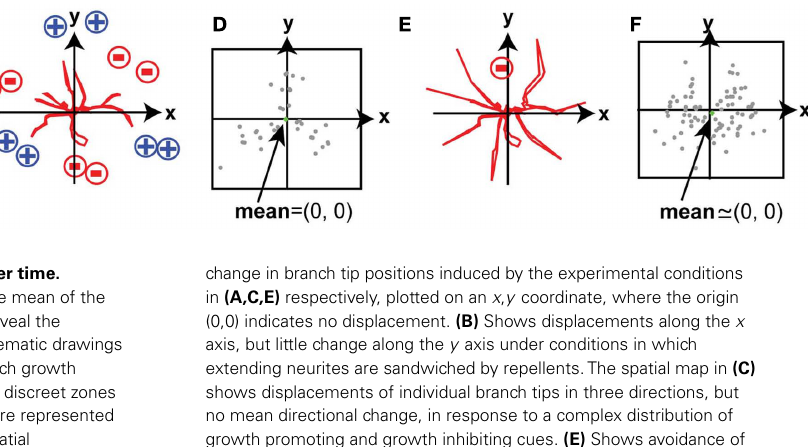
FIGURE 1 | Spatial displacements of branch tips over time. Examples of instructed growth of neurites, in which the mean of the displacement vectors of individual neurites does not reveal the presence of directional instructive signals. (A,C,E) Schematic drawings that show representative experimental contexts in which growth inhibitory cues are presented in a stripe assay (A) or in discreet zones (C,E) , where growth inhibition and growth promotion are represented by negative and positive signs, respectively. (B,D,F) Spatial representations of branch tip displacements, plotted as vectors of the